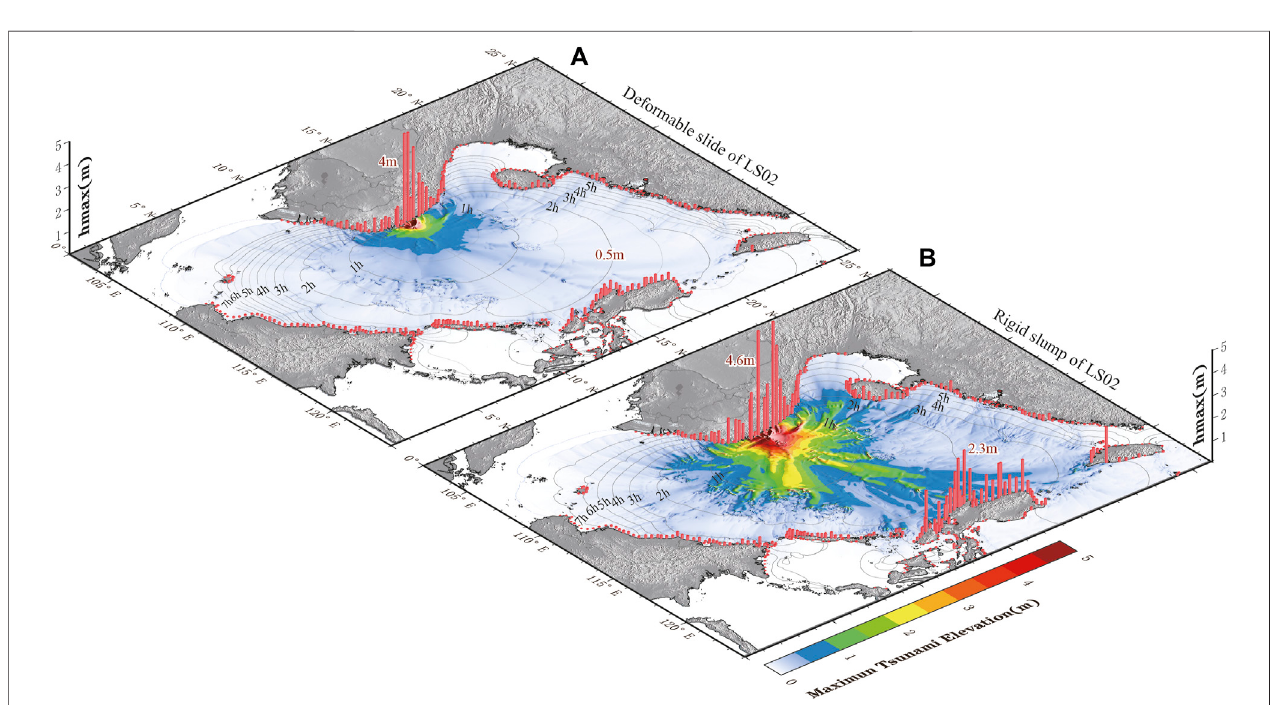
FIGURE 9 | The distribution of maximum wave height generated by (A) deformable slide and (B) rigid slump of LS02. The maximum wave amplitudes are also shown in red bars at synthetic wave gauges along the 20 m isobath.